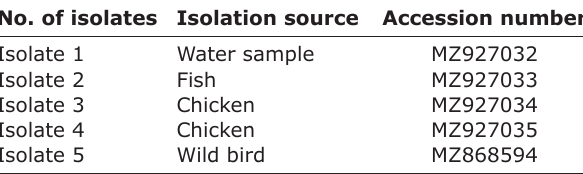
Table-2: The different Salmonella sequences obtained from Lake Qarun. No. of isolates Isolation source Accession